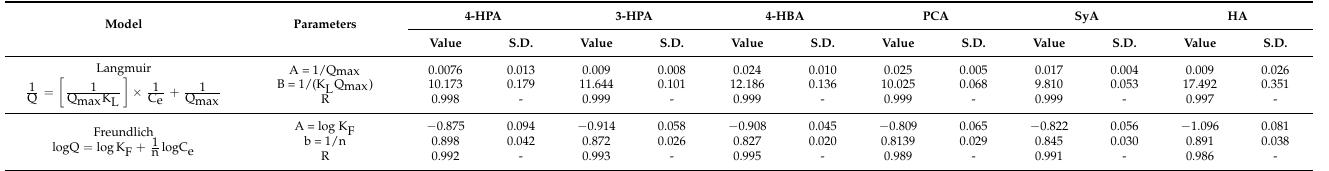
Table 1. Langmuir and Freundlich isotherm parameters obtained by non-linear fitting for the MIP polymer.